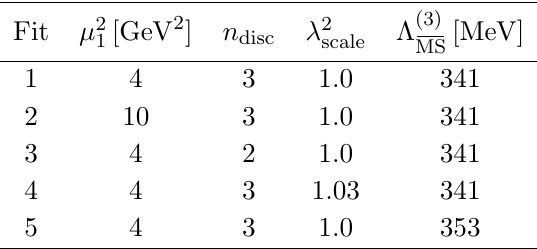
Table 1 . Lattice spacings. Table 2 . Fit choices regarding the determination of the renormalization